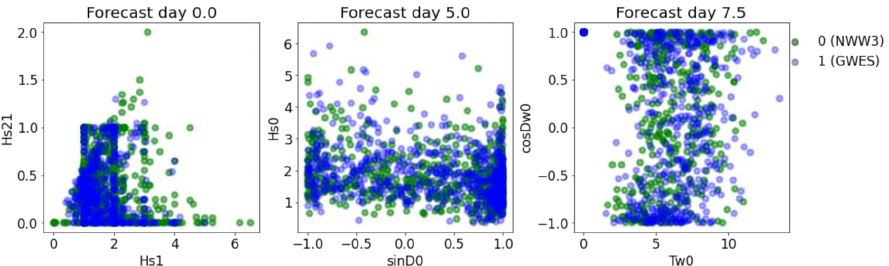
Figure 10. Relationship between the two most important features and the target for each dataset related to the three forecast leads considered. Green points represent the combinations in class 0 (NWW3) and blue points represent the combinations in class 1 (GWES). The three forecast times, 0, 5 and 7.5 days are indicated in the